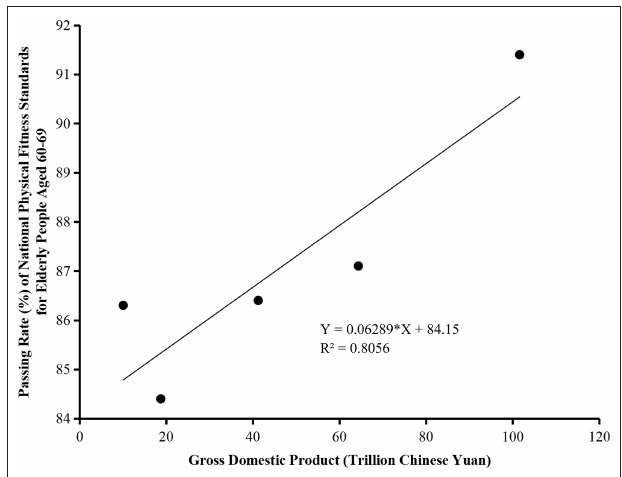
FIGURE 1 | Linear regression of gross domestic product and elderly people’s passing rate of national physical fitness standards in the five corresponding years: 2000, 2005, 2010, 2014, and